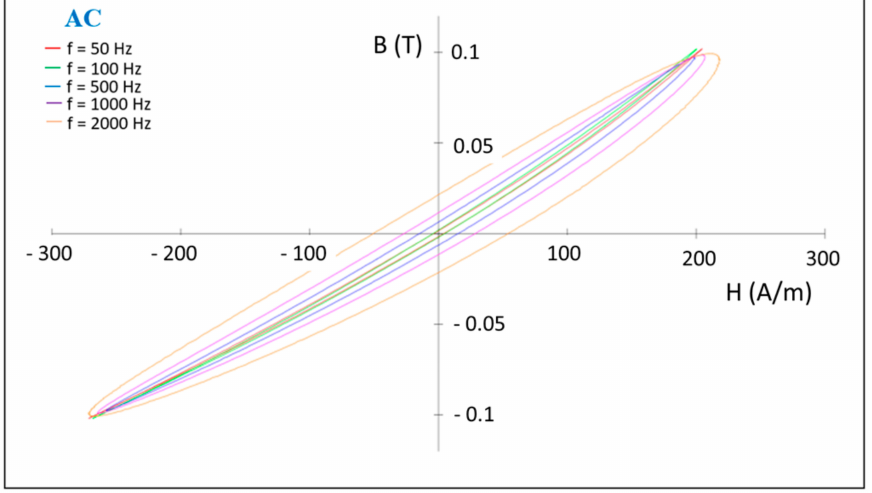
Figure 13. The influence of the frequency on the B–H hysteresis curves of the supermal- loy/Mn 0.5 Zn 0.5 Fe 2 O 4 composite compacts with 1 wt. % of MnZn ferrite, SPS-ed at temperature of 500 ◦ C, 0 min holding time. The induction level was seated at 0.01